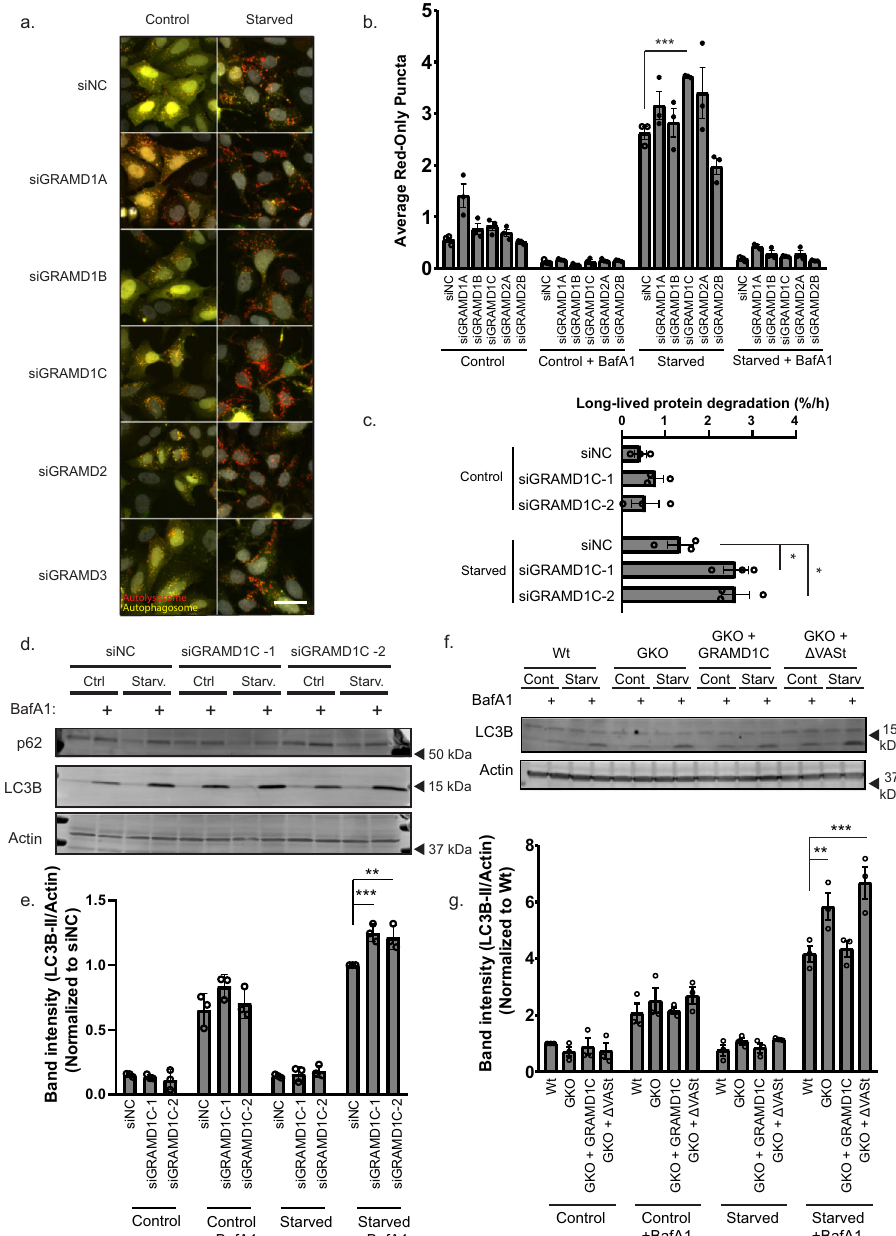
Fig. 3 | GRAMD1C is a negative regulator of starvation-induced autophagy. a U2OS cells stably expressing mCherry-EGFP-LC3B were transfected with siRNA againsttheindicatedgenesfor72hbeforeserumandaminoacidstarvationinEBSS for2h ± 100nM Ba fi lomycin A1(BafA1).Scale bar=20 µ m. b Quanti fi cation of data in ( a ). The bars represent the average number of red-only puncta per cell. Sig- ni fi cancewasdeterminedusingtwo-wayANOVAfollowedbyDunnett ’ scomparison testfrom n =3independentexperiments,>500cellspercondition.Errorbar=SEM. P value <0.0001. c U2OS cellswere incubatedin culturemedia supplemented with radioactive valine for 16h to allow degradation of short-lived proteins. The cells werethenstarved±100nMBafA1for4h,followedbytheanalysisofradioactive 14 C valine in the media and cells using a liquid scintillation counter. Signi fi cance was determined using a two-way followed by Tukey ’ s comparison test from n =3 independent samples. P value=0.0133 and 0.0145. d U2OS cells were transfected